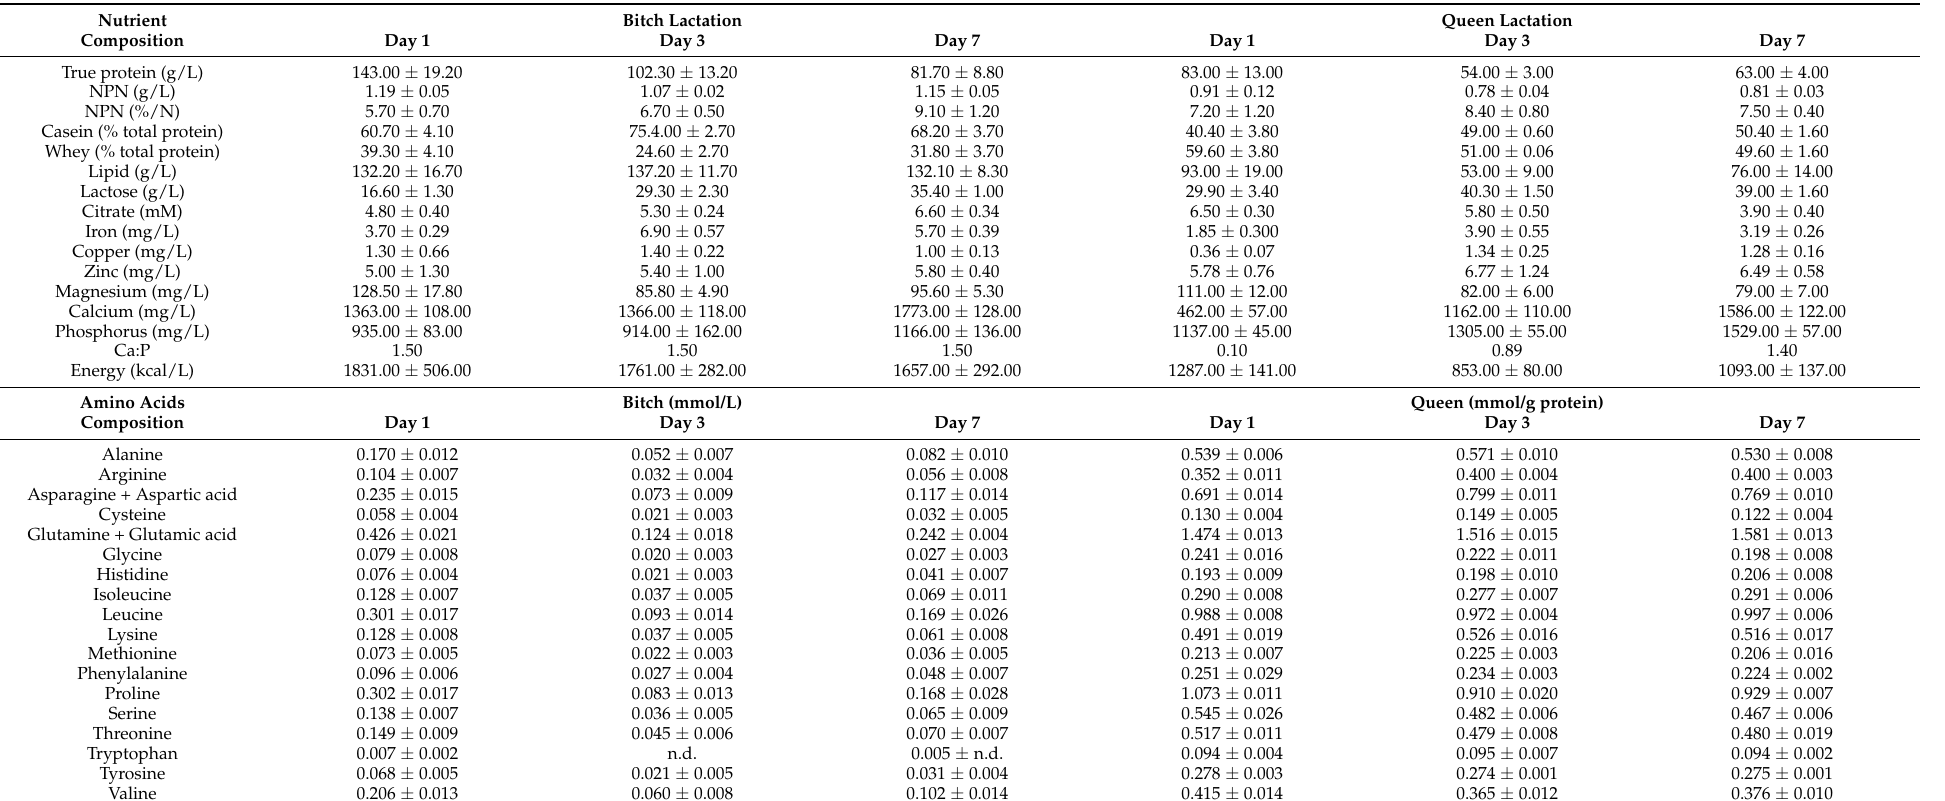
Table 2. Concentrations of nutrients throughout the first week of bitch and queen lactation